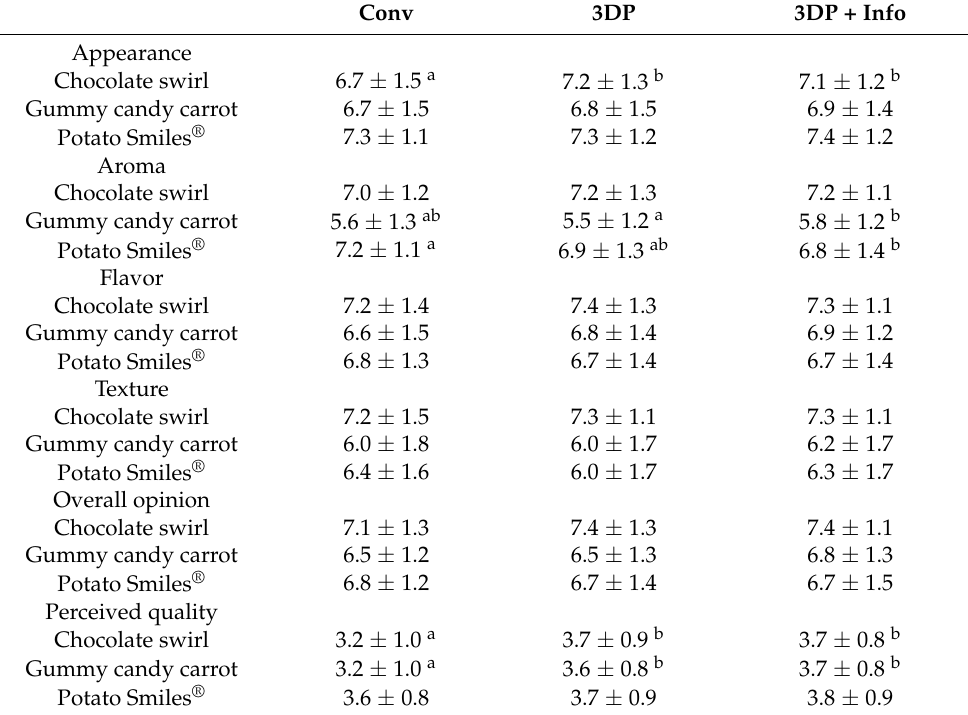
Table 2. Mean 1 sensory acceptance 2 and perceived quality 3 scores ± SD for chocolate swirls (n = 68), gummy candy carrots (n = 59), and potato Smiles ® (n = 59) when presented as conventionally produced (Conv), 3D printed (3DP), and 3D printed with product benefit information (3DP + Info). Conv 3DP 3DP + Info Appearance Chocolate